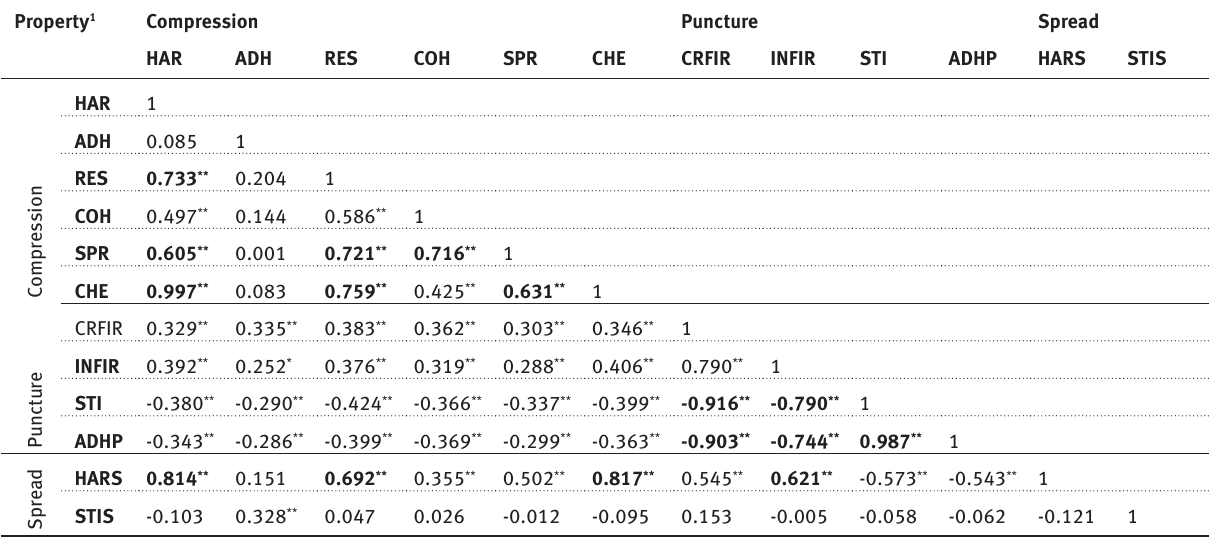
Table 3: Pearson correlations between the textural properties Property